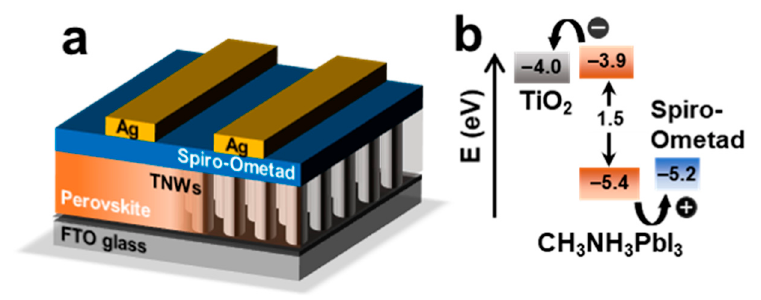
Figure 1. ( a ) Schematic illustration of the solid-state solar cell device based on TNWs and Perovskite, ( b ) Energy band alignment of the device structure.